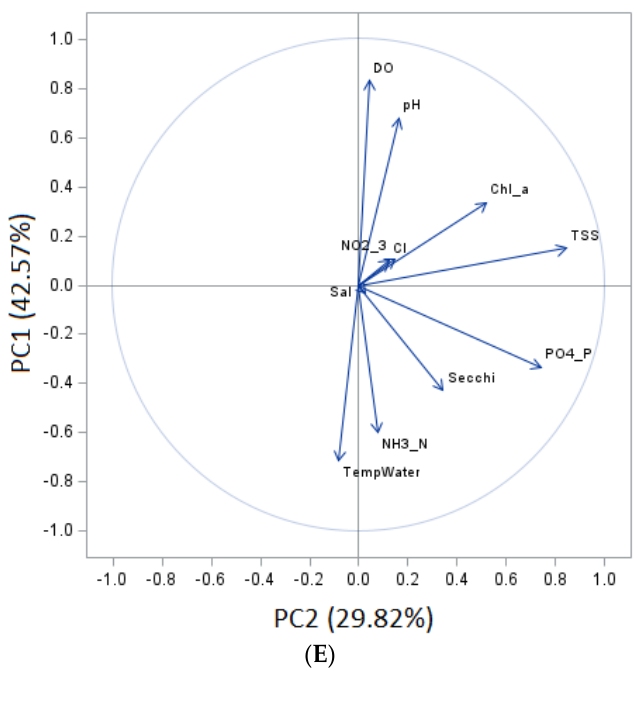
Figure 3. Principal component analysis for water quality variable loads using ( A ) Indian River, ( B ) Indian River Bay, ( C ) Rehoboth Bay, ( D ) Little Assawoman Bay, and ( E ) Lewes-Rehoboth Canal. Description of abbreviation in figure: TempWater = water temperature; N_NH3 = N as ammonia; Sal = salinity; N_NO 2_3 = N as nitrite+nitrate; DO = dissolved oxygen; Secchi = Secchi depth; Cl = chloride; P_PO 4 = P as phosphate; TSS = total suspended solids; Chl_a = chlorophyll-a. Table 3. Result of the ANOVA summarizing p values for null hypothesis and variance compo- nent analysis explained by watershed as the predictor variable. Abbreviation: Chl_a = chloro- phyll a; Cl = chloride; Sal = salinity; TempWater = water temperature; DO = dissolved oxygen; N-NO 2_3 = nitrite+nitrate; P-PO 4 = dissolved phosphate as P; Secchi = Secchi depth; N-NH 3 = dissolved ammonia as N; TSS = total suspended